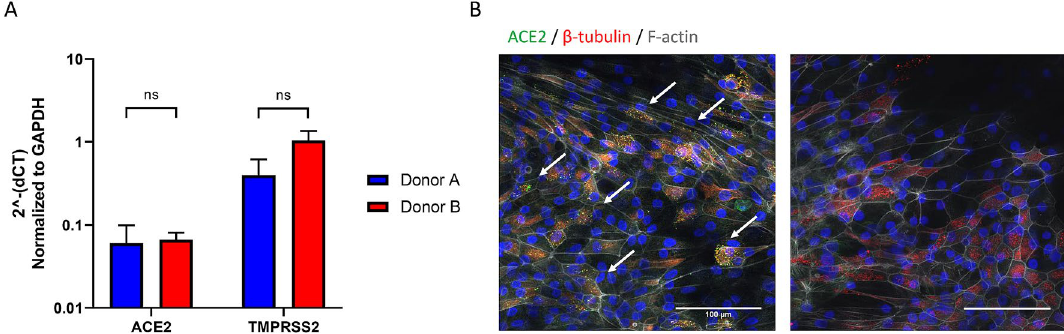
Figure 7. Characterization of ACE2 and TMPRSS2 expression in PREDICT96-ALI airway tissues. ( A ) Transcripts of ACE2 and TMPRSS2, both critical for establishing HCoV-NL63 and SARS-CoV-2 infection, were detected by RT-qPCR from PREDICT96-ALI airway tissue. ( B ) ACE2 protein expression was detected (left panel) on the apical surface of the tissue by in-situ IF in PREDICT96-ALI airway tissues (donor D). Representative ×40, confocal image (mean fluorescence intensity) showing ACE2 (green, red arrows) counterstained with nucleic acid (DAPI, blue) and actin (phalloidin, grey) compared to secondary-only control (right panel) with scale bar 100 µm. PREDICT96-ALI airway tissue from donors A and B were matured to 4 weeks ALI and shown to have a non-significant (ns) difference in ACE2 and TMPRSS2 gene transcript levels and ACE2 protein levels (data not shown) when compared to one another. Comparative CT values were determined using the method described by Schmittgen and Livak 35 and used to determine the relative quantification of gene expression using GAPDH as a reference gene. N = 3–4 tissue replicates per donor for both RT-q-PCR and